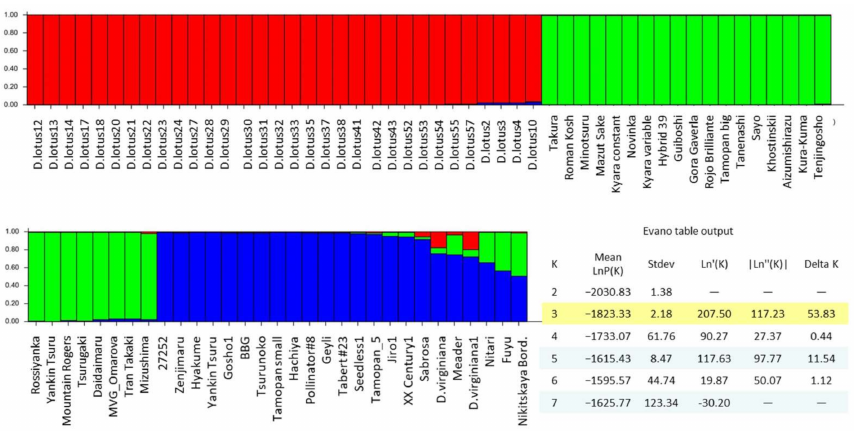
Figure 2. Population genetic structure among 80 Diospyros accessions based on 72 ISSR loci. Each genotype is represented by a vertical bar partitioned into K = 3. Each color represents the estimated membership fraction of the three genetic clusters (cluster 1 = red, cluster 2 = green, cluster 3 = blue). Table 4. Genetic diversity parameters for each genetic cluster based on SSR and ISSR markers. SSR ISSR Cluster